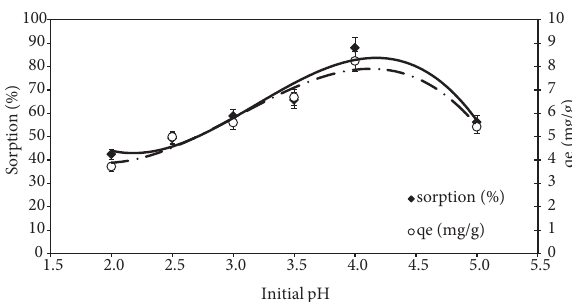
Fig. 3. Effect of initial pH on Cu 2+ sorption onto eggshell